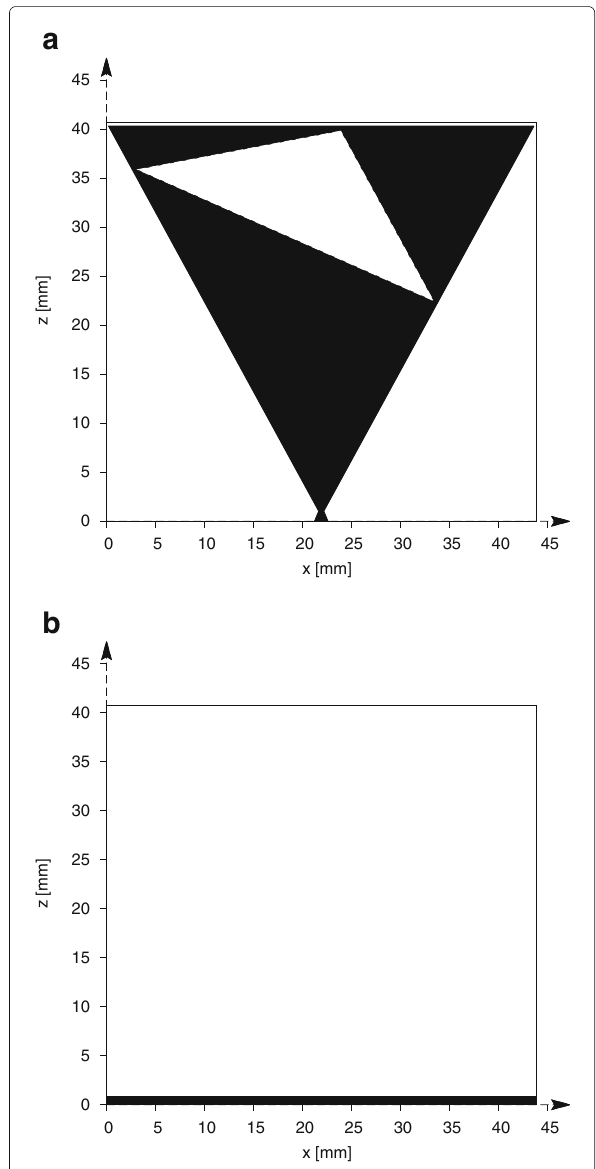
Fig. 5 SbD validation (LTE-2100 and LTE-3500 bands). Front ( a ) and back ( b ) views of the optimized